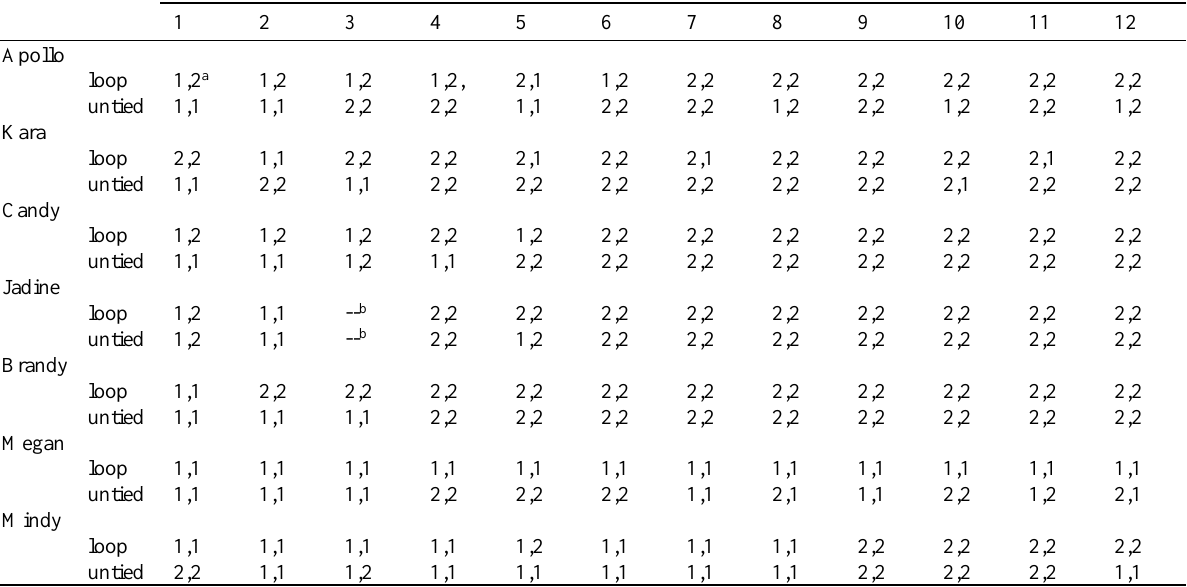
Trial-By-Trial Data for the Number of Lengths of Rope That Were Initially and Finally Grasped by the Chimpanzees in the Loop and Untied Rope Conditions